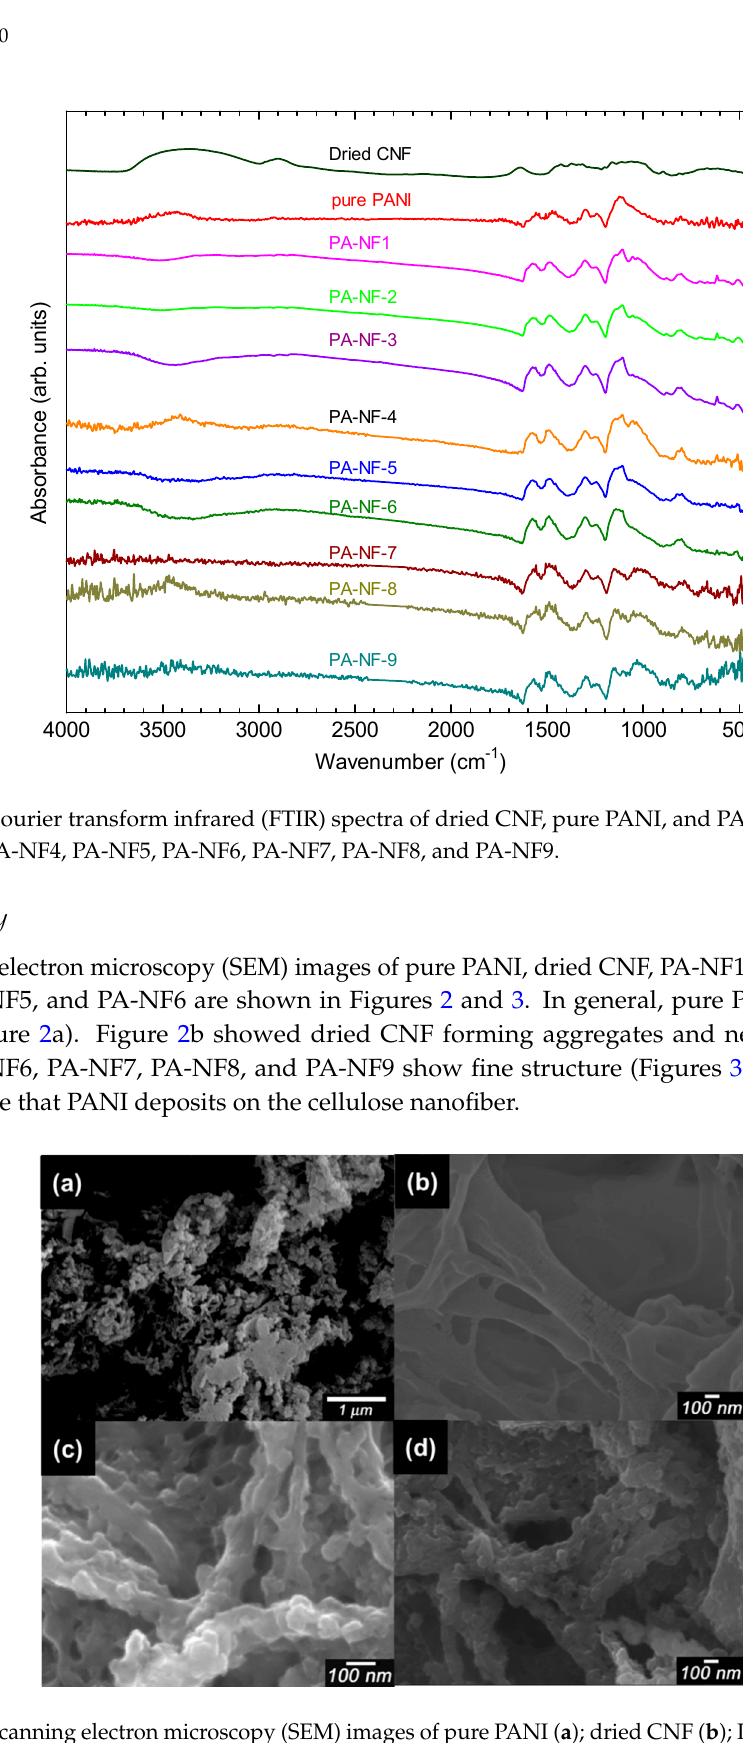
Figure 2. Scanning electron microscopy (SEM) images of pure PANI ( a ); dried CNF ( b ); PA-NF1 ( c ); and PA-NF2 ( d ). PA-NF1 (dried CNF/aniline = 150, feed %). PA-NF2 (dried CNF/aniline = 100, feed %).